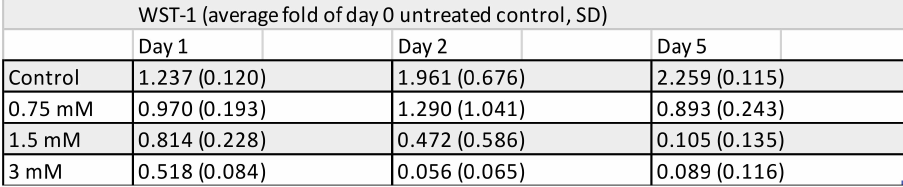
Figure 5. Viability changes in pulp cells over the course of the 5-day exposure to 0.75, 1.5, and 3 mM TEGDMA as detected by the Water-Soluble Tetrazolium-1 assay (sample number: n = 3).